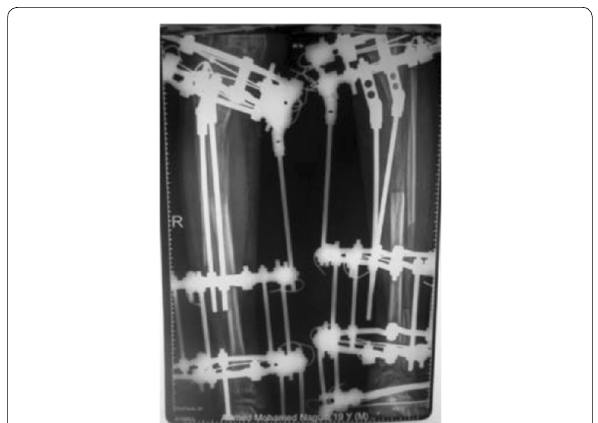
Fig. 4 Malalignment of the tibia during distraction and application of hinges to correct it